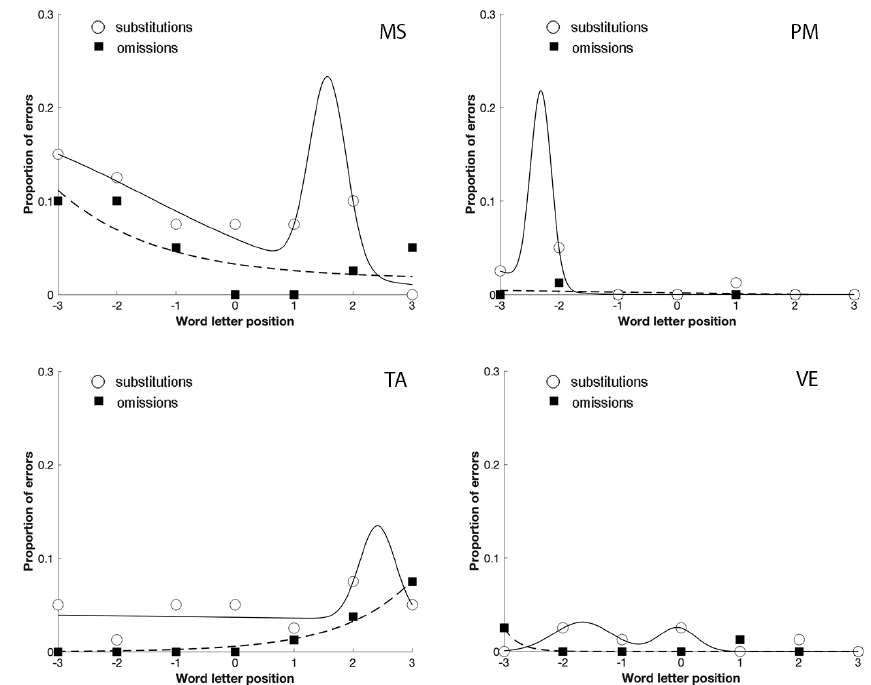
Figure 4. The distribution of omission and substitution errors made by the four patients with a prevalence of substitution errors in Experiment 2 in the unspaced condition. 0 corresponds to the central letter in the string, positive values to the letters on the right and negative values to the letters on the left. Brain Sci. 2021 , 11 , x FOR PEER REVIEW